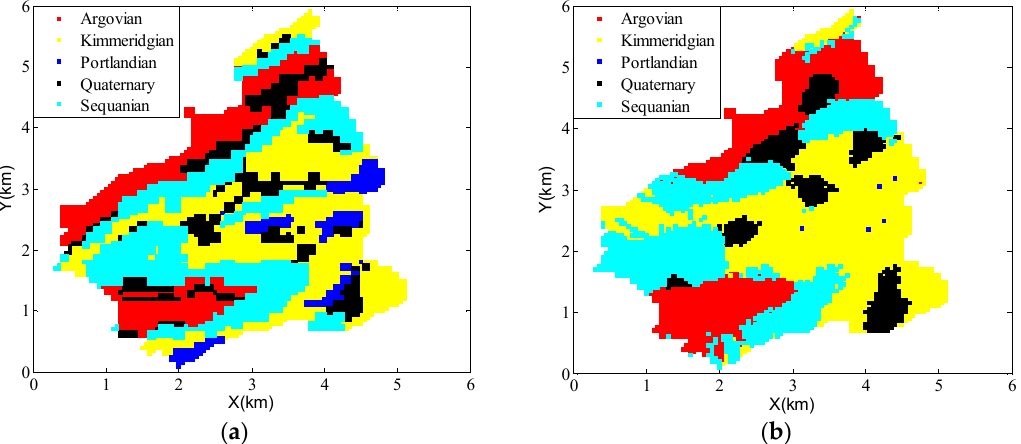
Figure 8. ( a ) Original image obtained from R software data set (jura.grid); ( b ) Classification maps generated by MANN with interaction noise. Simulations are conditioned on 359 samples in Jura lithology data set, note the small Quaternary patches (visualized in black) neglected in (a) are successfully recovered in the result of the proposed method (b). Table 3. Prediction accuracy comparison of the Jura data set.